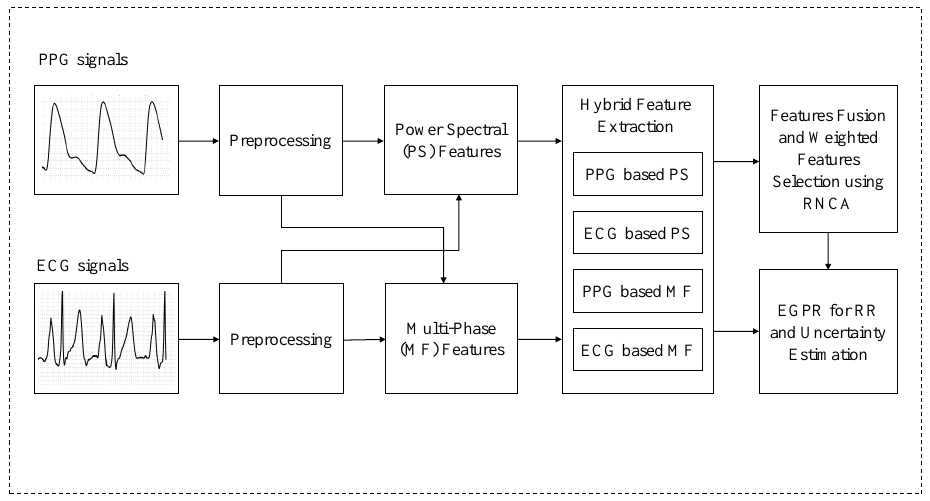
Figure 1. Block diagram of the proposed methodology using exact Gaussian process regression (EGPR) with hybrid feature extraction, feature fusion, and weighted features selection using the RNCA